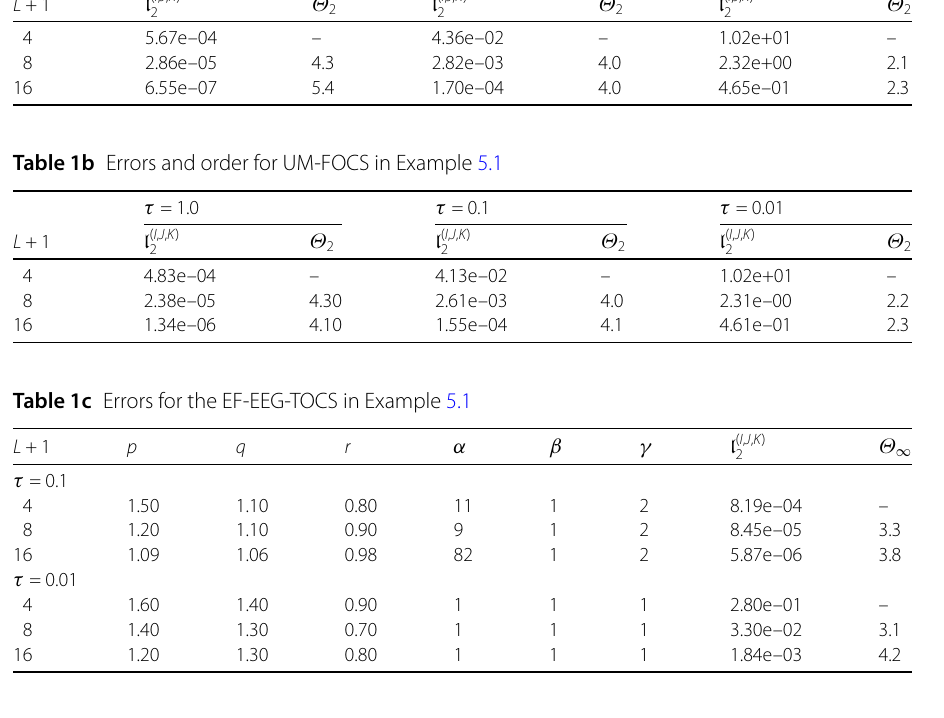
Table 1d Errors for the EF-EEG-TOCS in Example 5.1 at τ = 0.01 L + 1